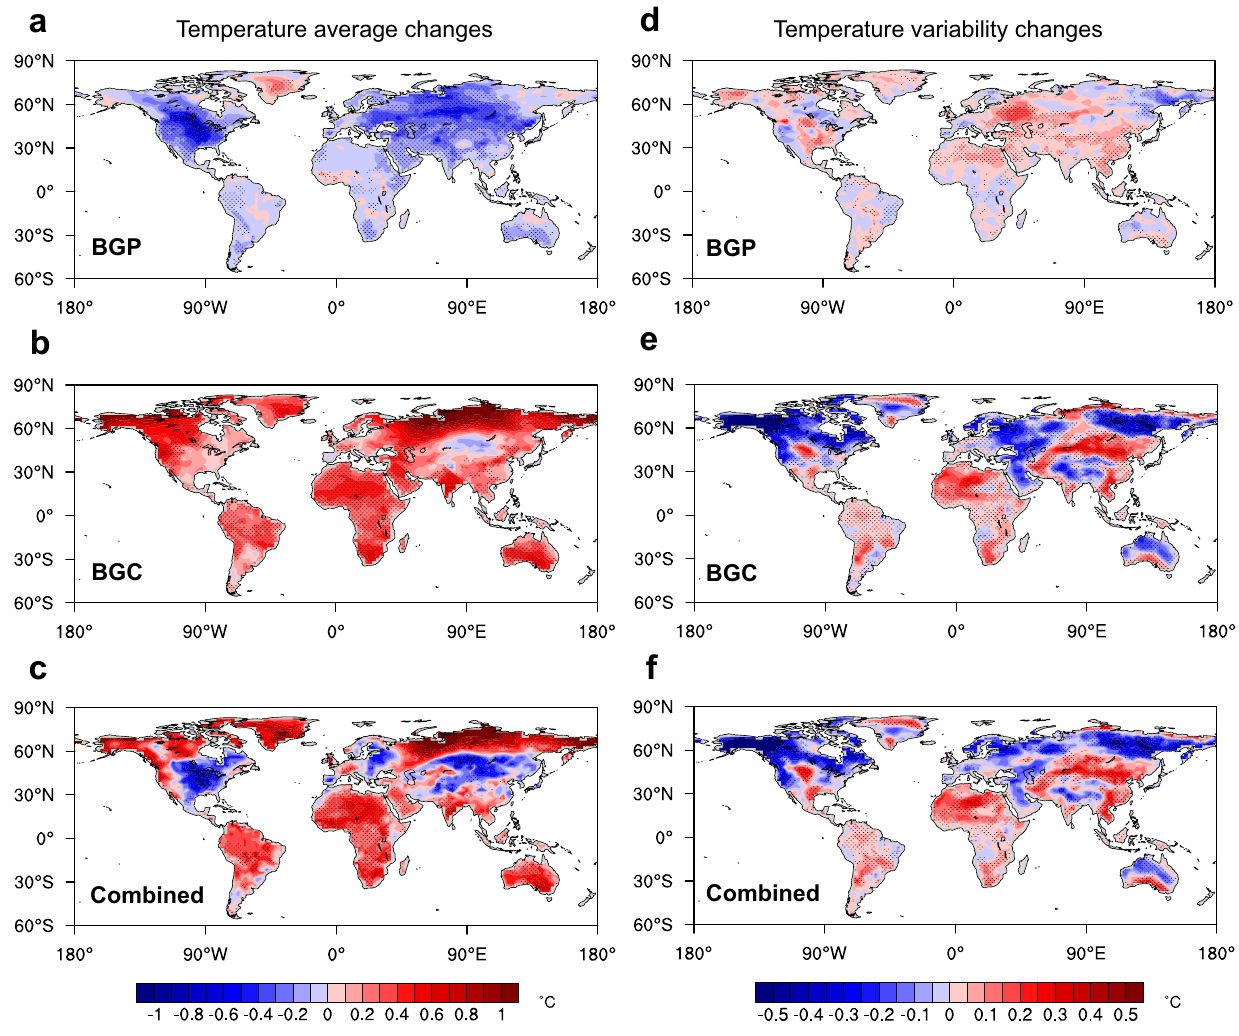
Fig. 3 Spatial patterns of changes in annual mean surface air temperature (SAT) and day-to-day SAT variability during 1993 – 2012 due to biogeophysical (BGP) and biogeochemical (BGC) impacts of historical land-use and land-cover change. a – c The ensemble median of annual mean SAT changes (°C) induced by ( a ) BGP, ( b ) BGC, and ( c ) their combined impacts. d – f The ensemble median of annual mean day-to-day SAT variability changes (°C) induced by ( d ) BGP, ( e ) BGC, and ( f ) their combined impacts. Dots indicate where more than two-thirds of members agree on the sign of